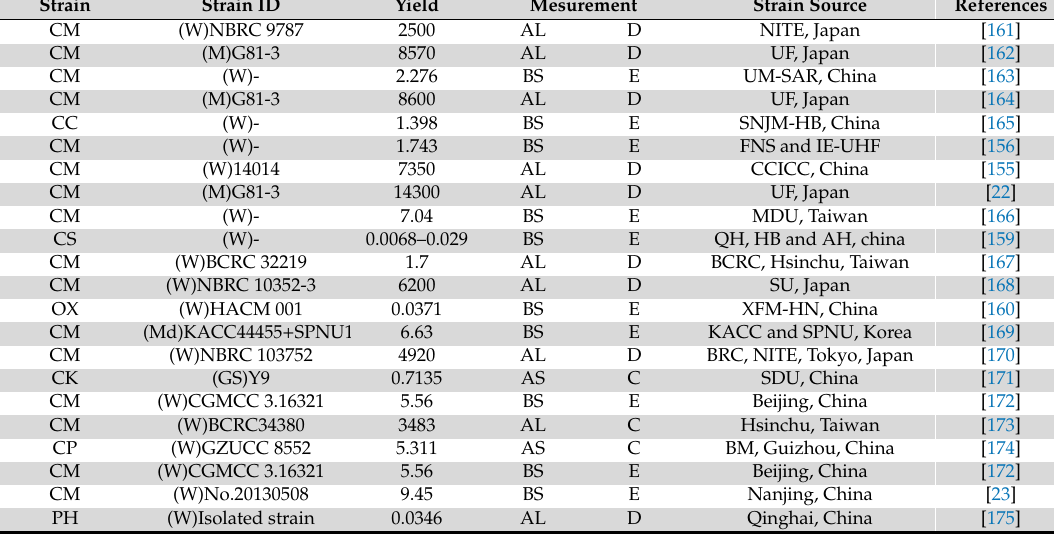
Table 2. COR production of di ff erent strains of Cordyceps and Ophiocordyceps from 2007 to